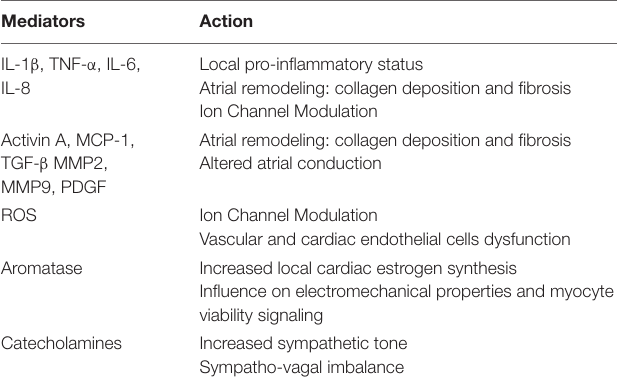
TABLE 2 | The main EAT-secreted mediators and their contribution to